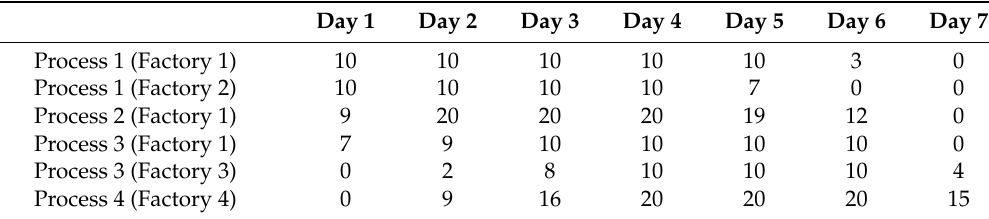
Table 6. Production plan–Demand for marketing